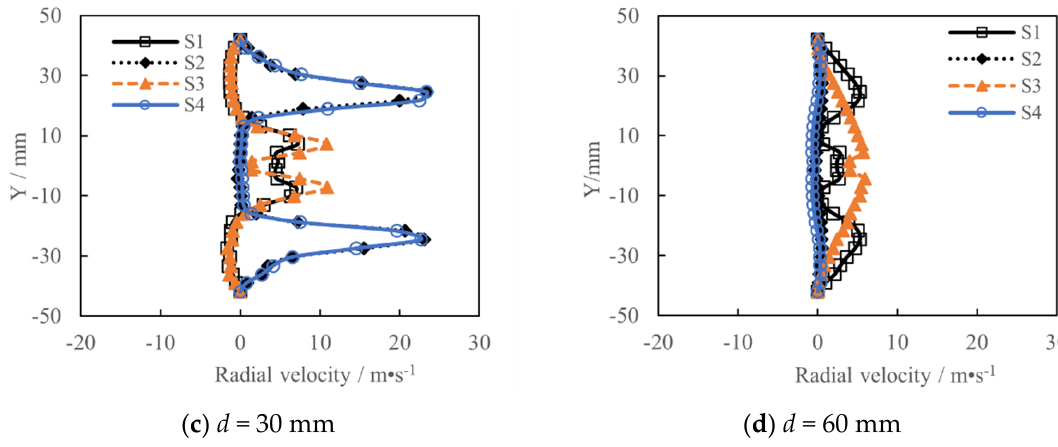
Figure 8. Radial profile of radial velocity at different axial sections.